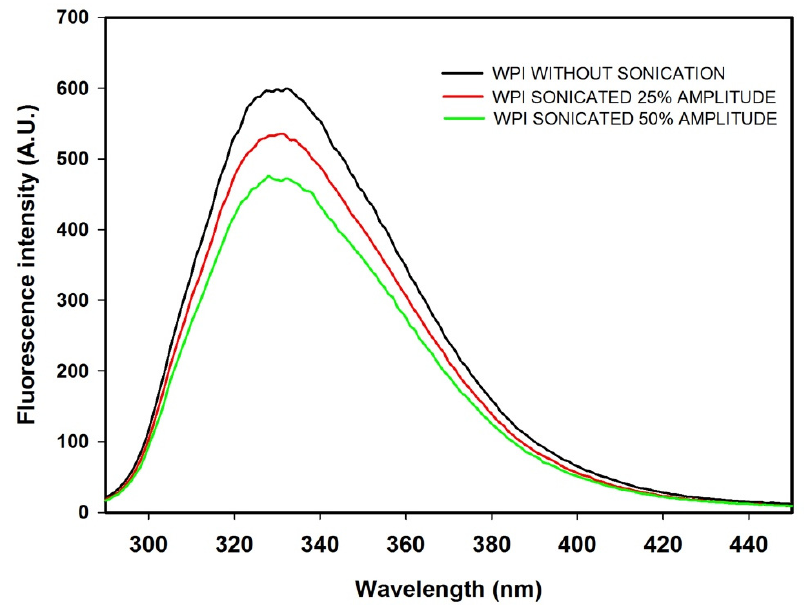
Figure 4. Effect of ultrasound treatment (25 and 50% of amplitude) on intrinsic fluorescence spec- trum.